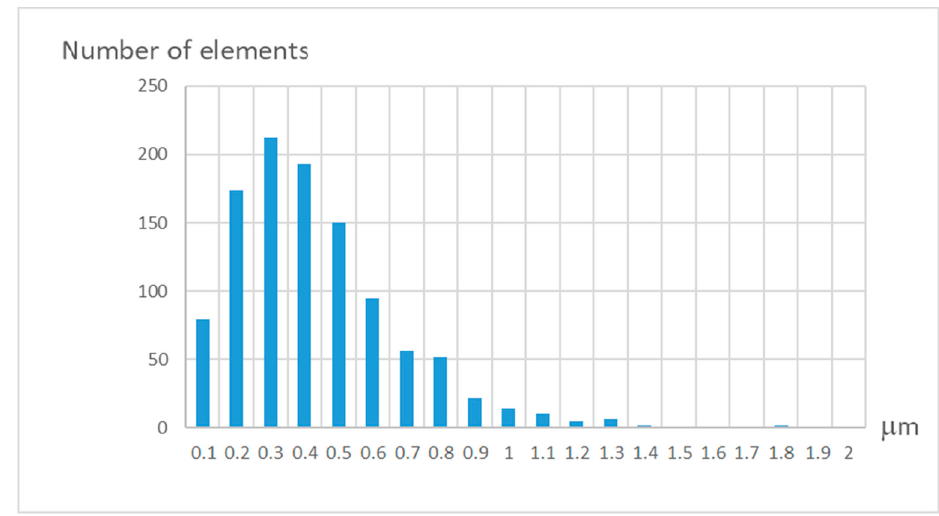
Figure 6. Histogram of pattern elements’ displacement.